Question: Provide a one-line summary of what is displayed.
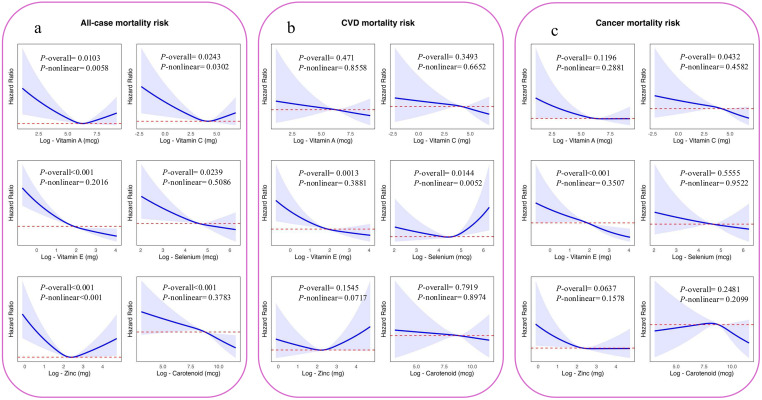
Answer: long description. Restricted cubic spline curve for the association of dietary antioxidants with all-cause and cause-specific mortality. (a) All-cause mortality risk; (b) CVD mortality risk; (c) cancer mortality risk.